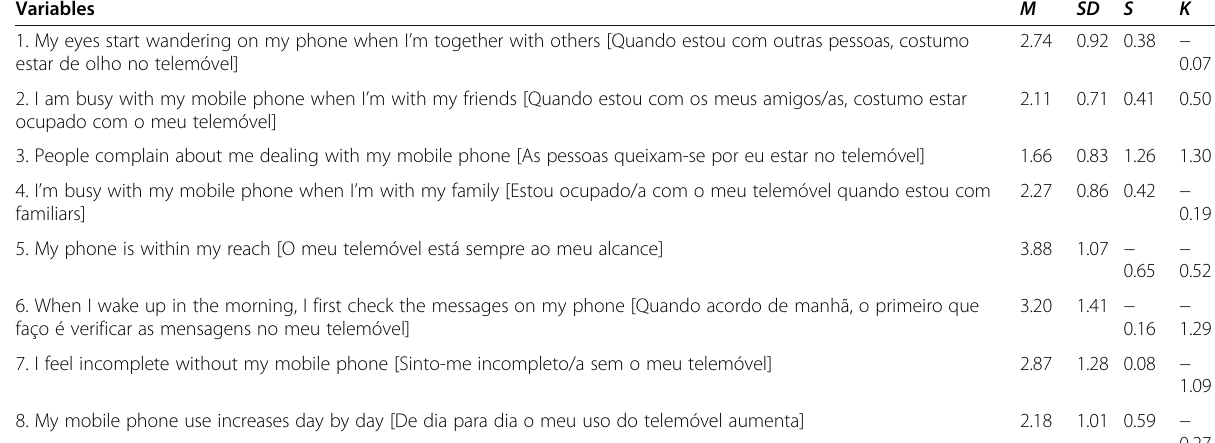
Table 2 Means (M), standard deviations (SD), skewness (S), and kurtosis (K) for PS-8 items, its two factors, and the other study variables ( N =